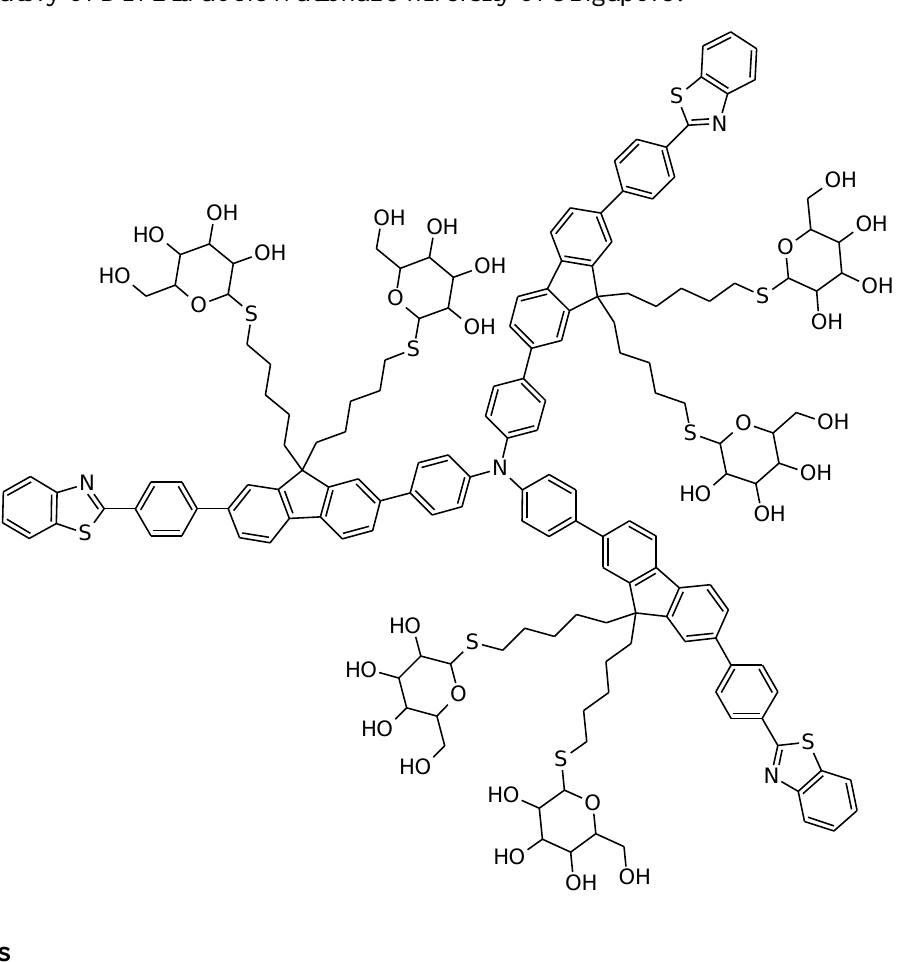
Figure 10. Chemical structure of the star-shaped glycosylated conjugated oligomer, fluorescent-tagged glucose